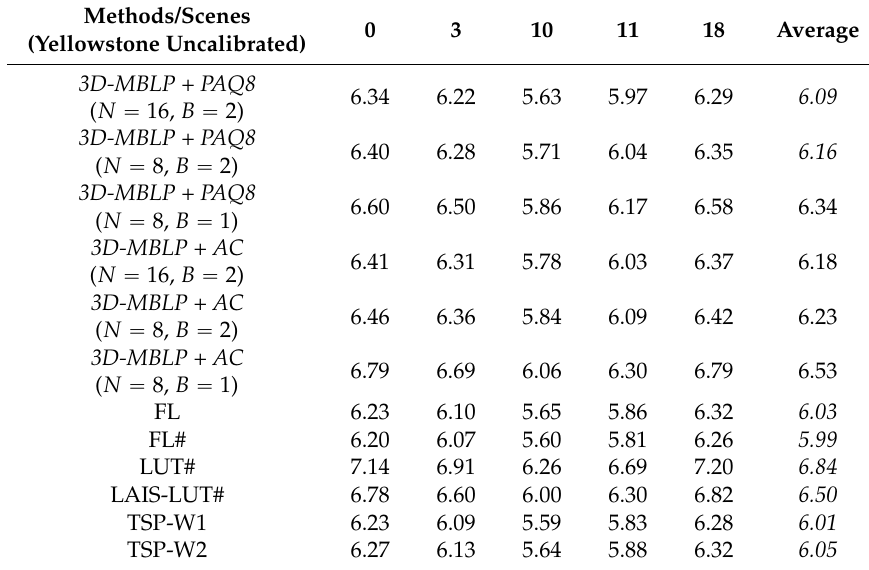
Table 15. Comparison with other lossless compression methods (16-bit uncalibrated images). The results are reported in bits-per-sample (BPS).